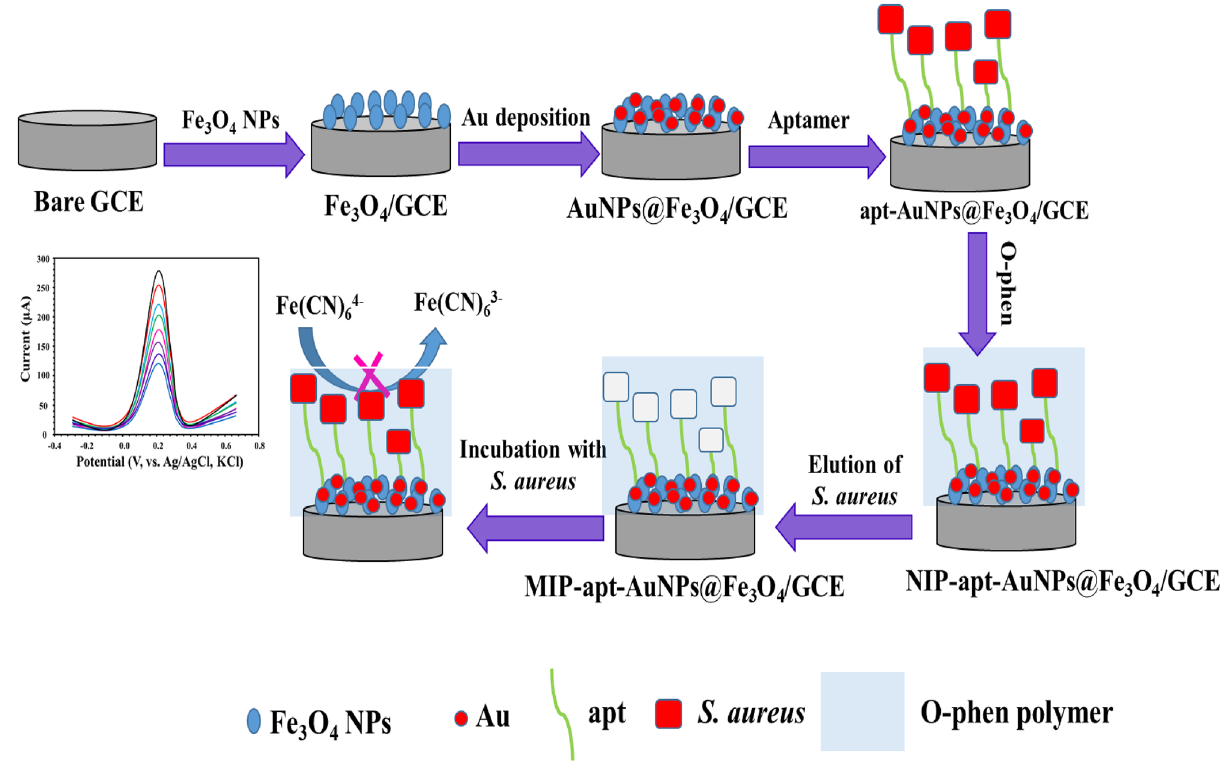
Figure 1. Representative diagram for the fabrication of the molecularly imprinted based aptasensor and its use for the determination of S. aureus .